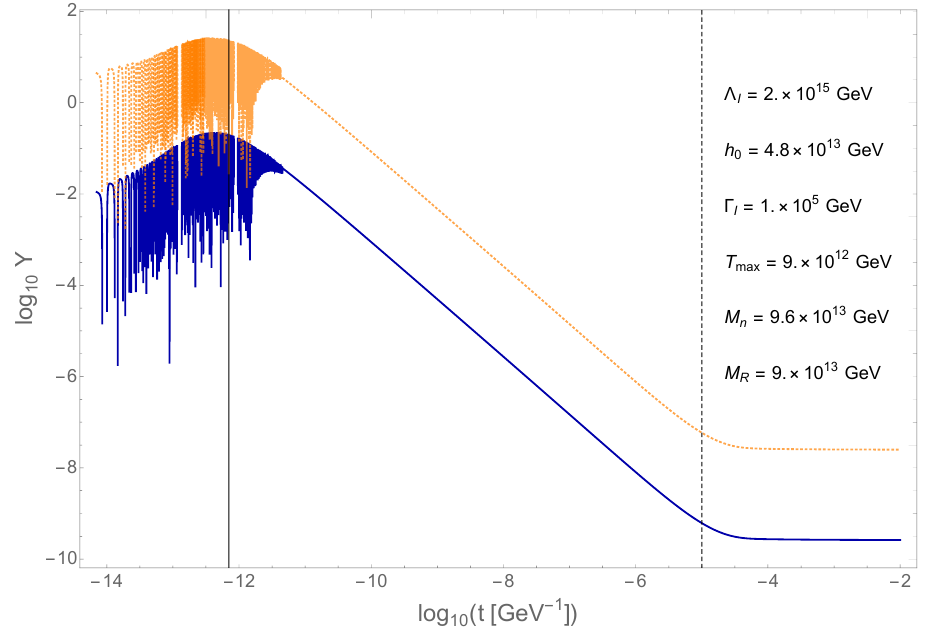
Figure 8 . The lepton asymmetry from forced relaxation. The blue-solid line shows an example with (cid:3) n = M n = 2 h 0 , and the orange-dotted line shows an example with (cid:3) n = T . The vertical solid line indicates the time when the maximum temperature is reached, and the vertical dashed line indicates the beginning of radiation dominated